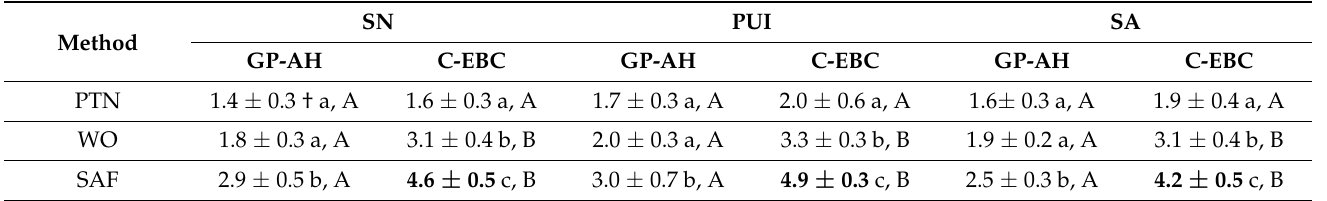
Table 1. Push-out bond strength of root fillings made of two root-filling materials, in oval root canals prepared with three different instrumentation methods and subjected to different activation protocols of the final irrigant ( n =